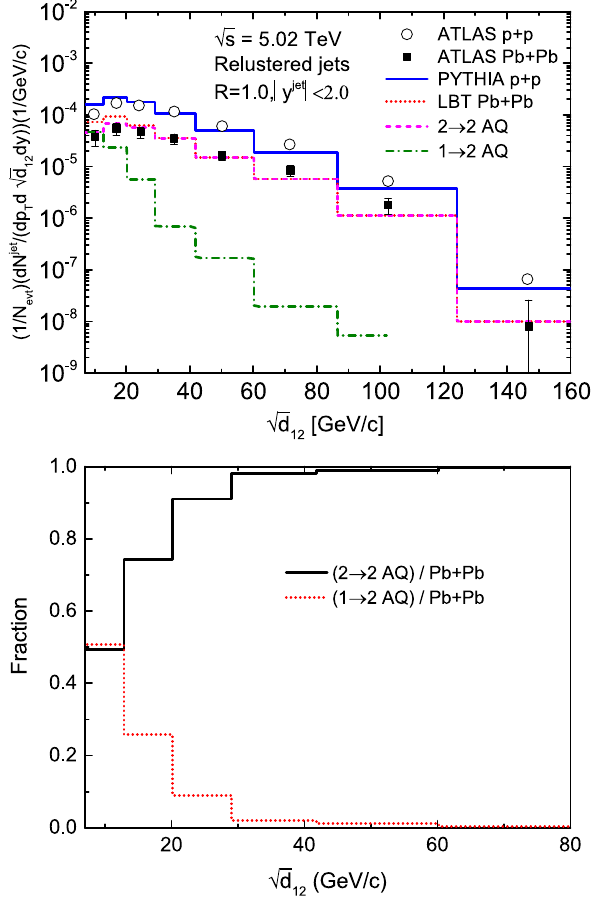
Fig. 5 Distributions of splitting scale 251 GeV/c in p + p and Pb + Pb collisions as well as the contribu- tions from different processes in Pb + Pb (top), and the comparison with experimental data [83]. The relative contribution fractions from the process 2 → 2 (without changes of jet substructures) and 1 → 2 (with changes of jet substructures) to jet (bottom)